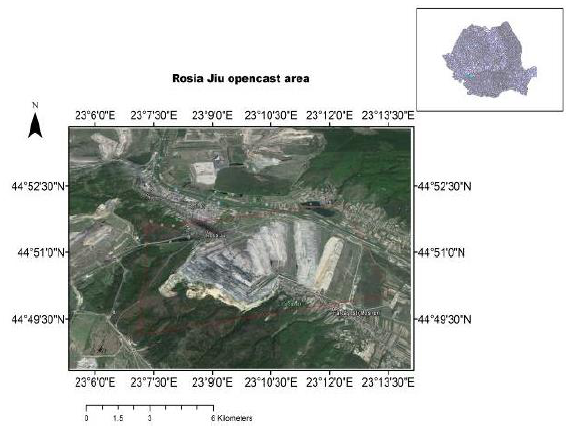
Figure 1.Rosia Jiu opencast area, Gorj County. ©Google Earth, 2016